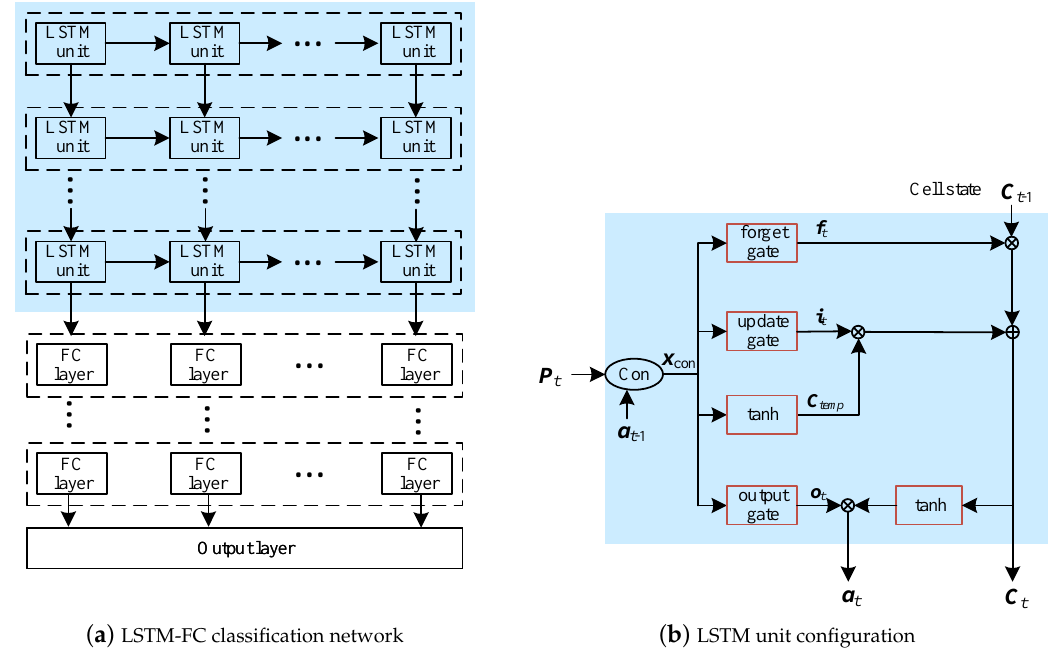
Figure 3. Temporal LSTM (long short-term memory)-FC (fully connected) classification network ( a ) and unit configuration ( b